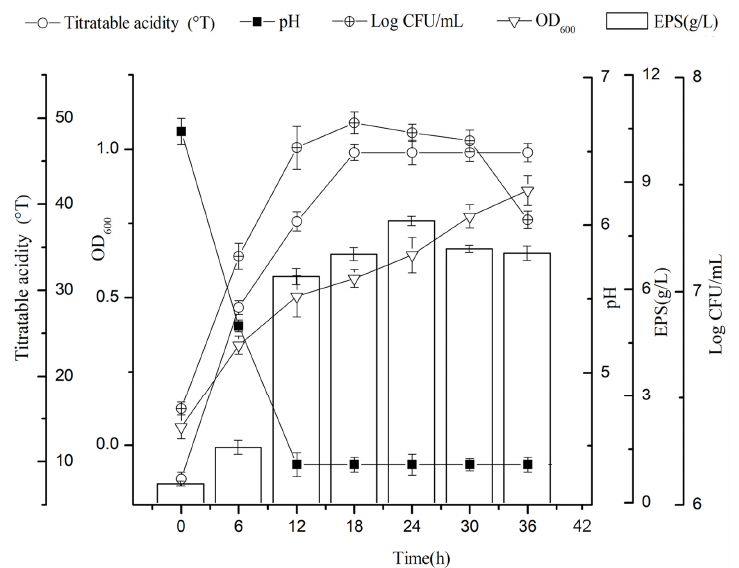
Figure 1. Growth curve of bacterial growth and EPS production by Lc. citreum 1.2461 at 37 °C from 0 to 36 h.